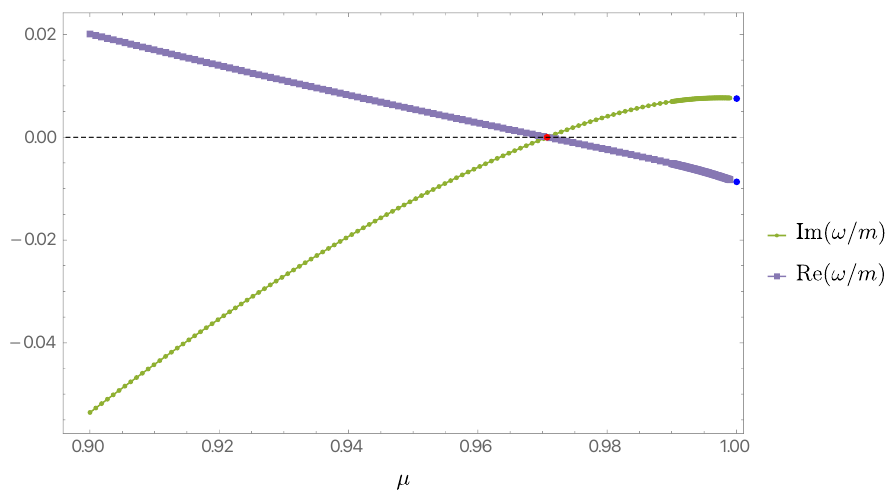
Figure 10 . Imaginary (green disks) and real (purple squares) parts of ω as a function of µ for fixed α = 1 , q/m = 0 . 5 and m r + = 1 . The red point with Im ω = 0 and Re ω = 0 is the onset of the instability and the merger point between RN and hairy black holes (obtained using the time dependent analysis of section A.2 and, independently, the static analysis of section 3.2). The blue points at µ = 1 correspond to the frequency computed directly at extremality using the method outlined in section